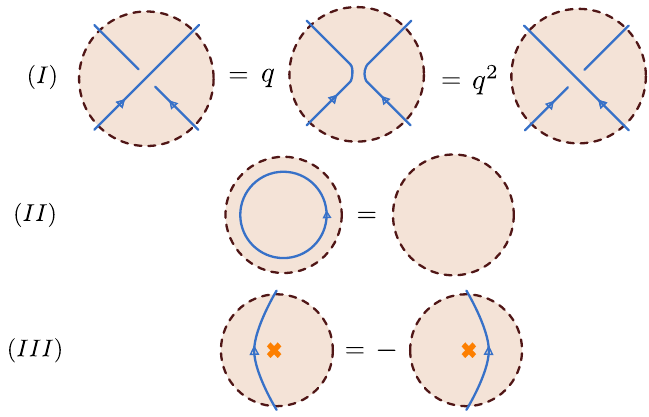
Figure 6 . The skein relations de(cid:12)ning Sk( M; gl ( N )).